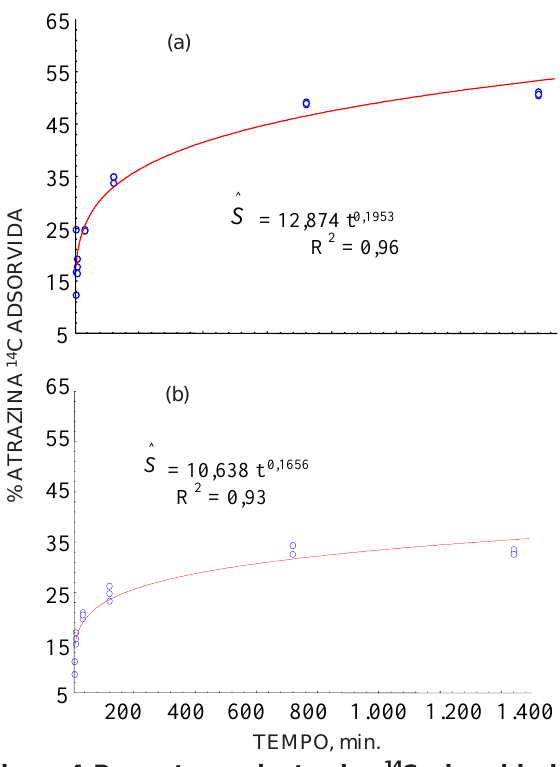
TEMPO, Figura 4. Percentagem de atrazina- 14 C adsorvida do total adicionado em amostras de LR. Solo (a) e argila com matéria orgânica (b).